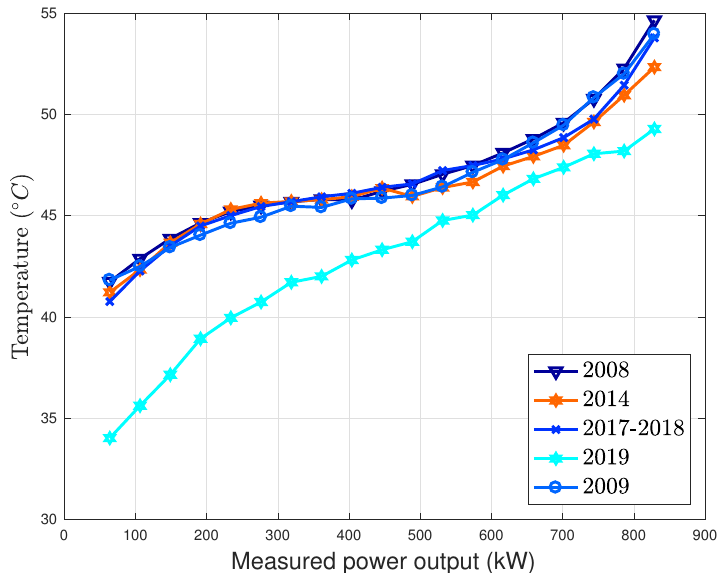
Figure 7. The power–gear oil temperature curve. Data sets 2008, 2014, 2017–2018 and 2019.